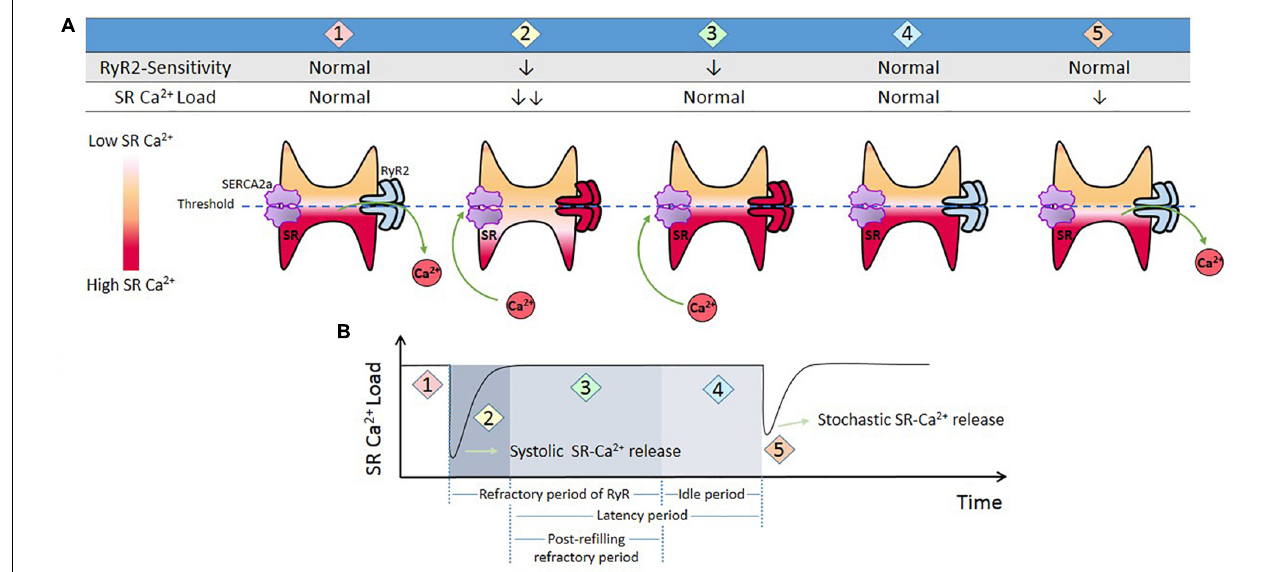
FIGURE 4 | Threshold concept. (A) Cartoon that represents different conditions of RyR2 sensitivity and SR-Ca 2 + load during Ca 2 + release from SR. When the cell triggers a Ca 2 + transient (1), SR Ca 2 + load diminishes and RyR2s enter in a refractory period (2). SR Ca 2 + uptake produces SR Ca 2 + recovery (3). During this period there are no spontaneous releases, i.e., RyR2 remained refractory in spite of the fact that SR level has recovered completely (SR threshold ). This period is followed by what has been named an “idle” period, by Belevych et al., 2012, (4) in which, after SR-Ca 2 + load and RyR2s recovering, a stochastic activation of RyR2 may trigger a spontaneous release. (B) Schematic representation of time dependent changes of SR Ca 2 + t (1 and 2), and refractoriness (2 and 3) after a stimulus-induced Ca 2 + transient. (4) “Idle” period during which a spontaneous SR-Ca 2 + release occurs. We called post-refilling refractory period to the period of time needed for refractoriness to recover after SR Ca 2 + threshold was